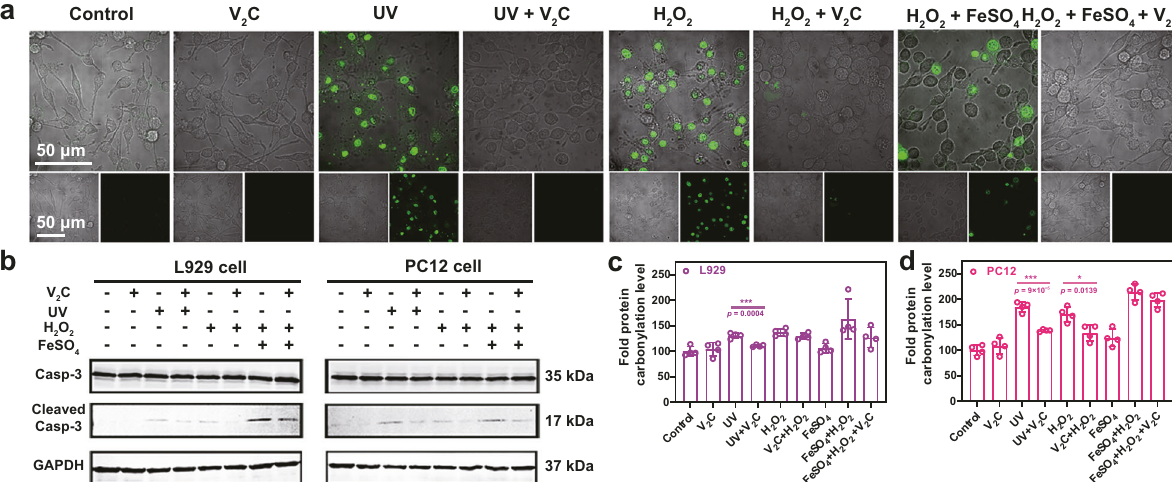
Fig. 7 Protection of cellular components from ROS-induced damage by V 2 C MXenzyme. a CLSM images of Caspase-3/7 activity in PC12 cells after different treatments. A representative image of three replicates from each group is shown in ( a ). b Western blot analysis of caspase-3, cleaved caspase-3, and GAPDH expressions in both L929 cells and PC12 cells after different treatments. Protein carbonylation level of both c L929 cells and d PC12 cells after different treatments ( n = 4 for each group). Data presented as mean ± SD and asterisks indicated signi fi cant difference (* p < 0.05, ** p < 0.01, and *** p < 0.001) as compared with the control group using one-way analysis of variance red to green when attacked by the product of lipid peroxidation 43 .